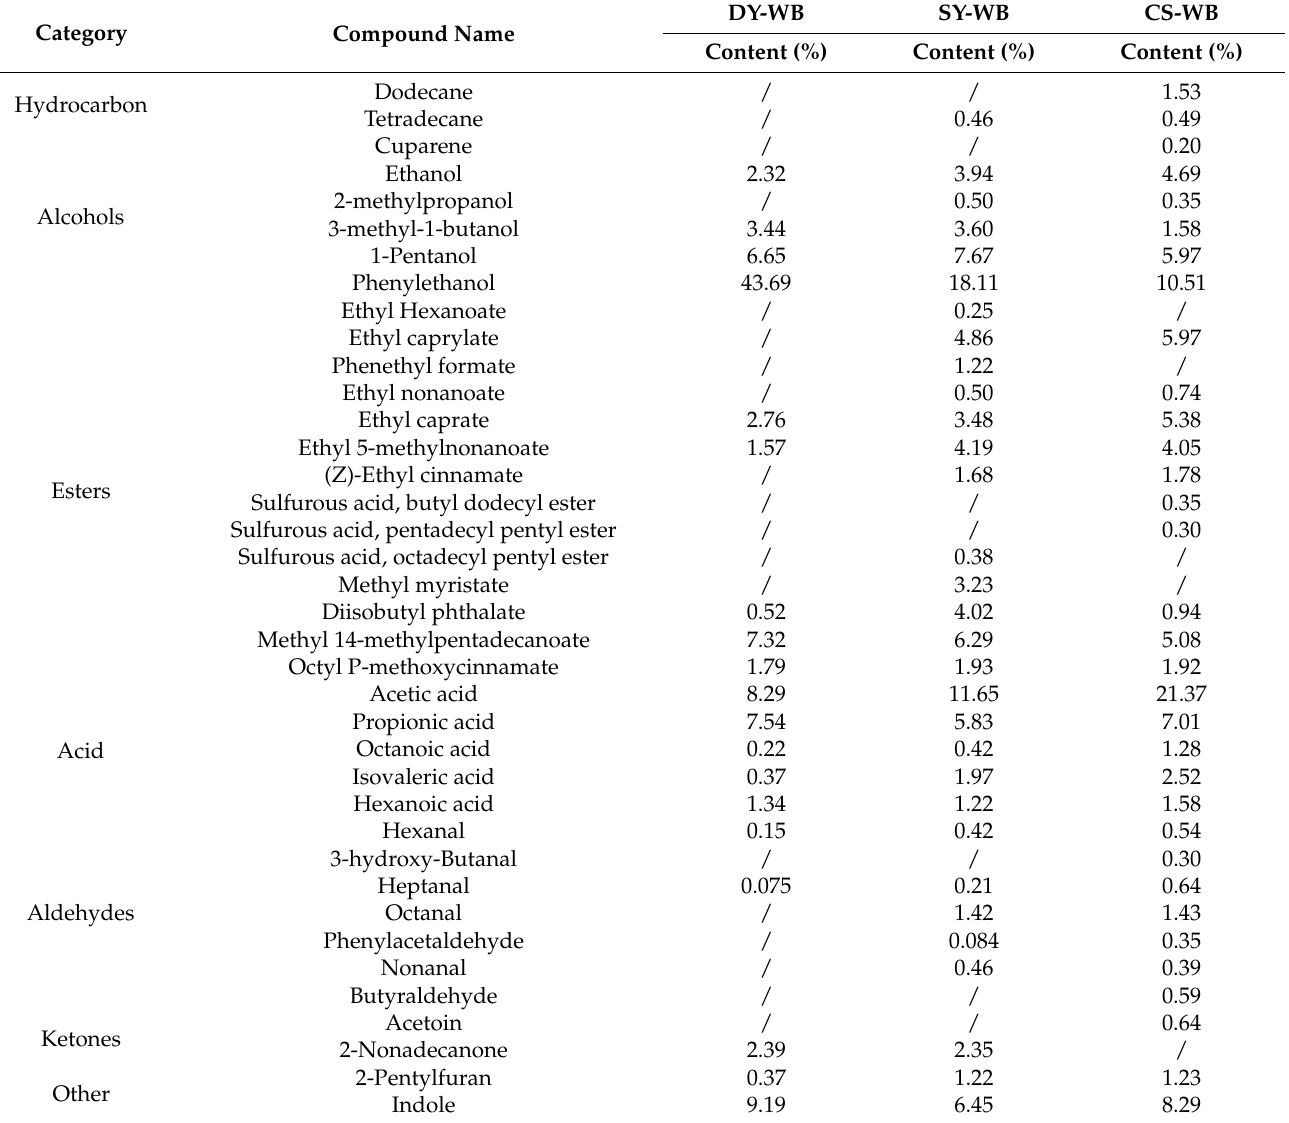
Table 6. Composition of flavor substance in different whole wheat steamed